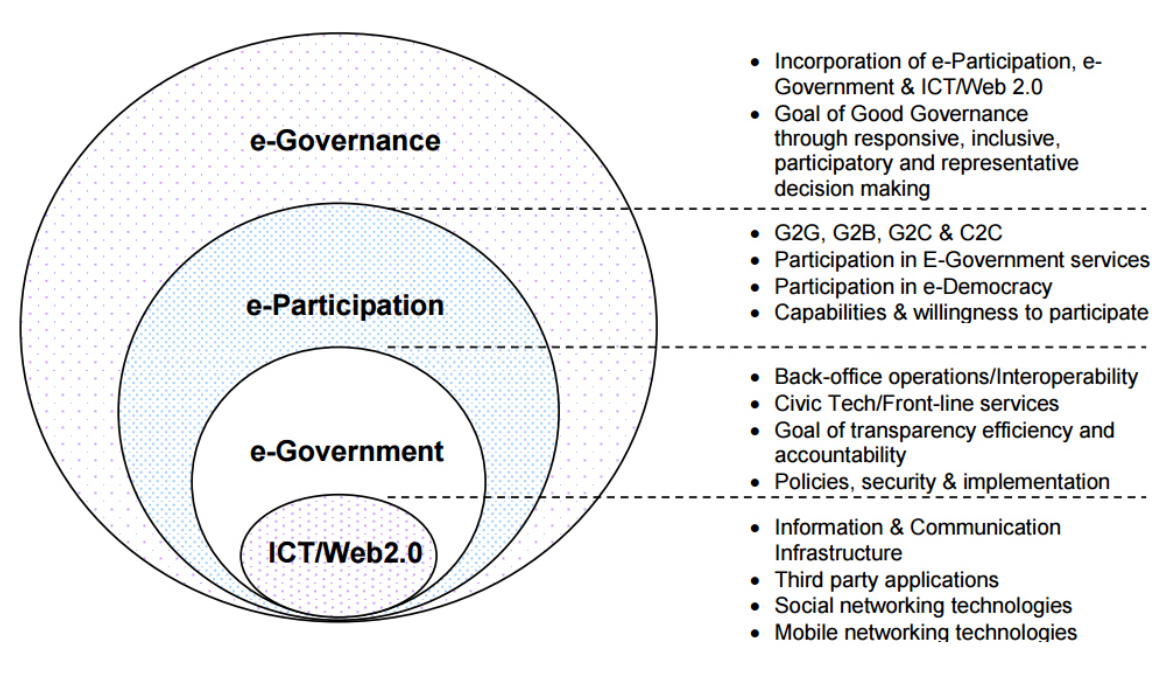
Figure 2: Evolutionary E-Governance 2.0 Model (Source: